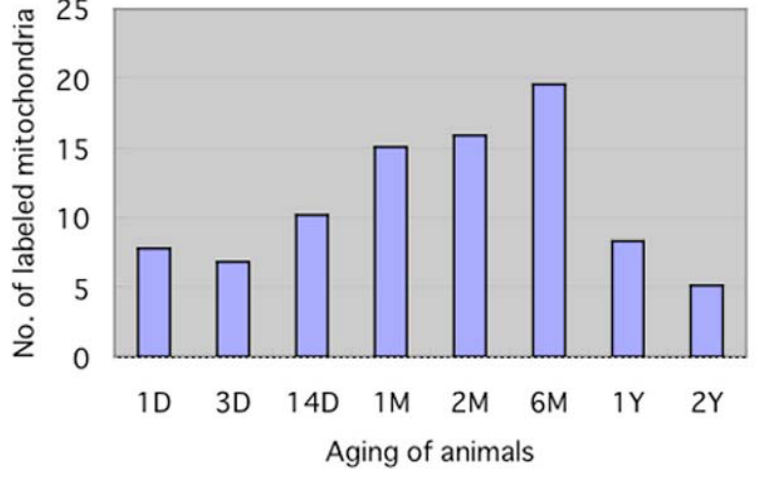
FIGURE 5 . Histogram demonstrating aging change of the total number of mitochondria labeled with 3 H-leucine, showing protein synthesis per cell profile area in binucleate hepatocytes, at respective aging groups from postnatal day 1 to postnatal month